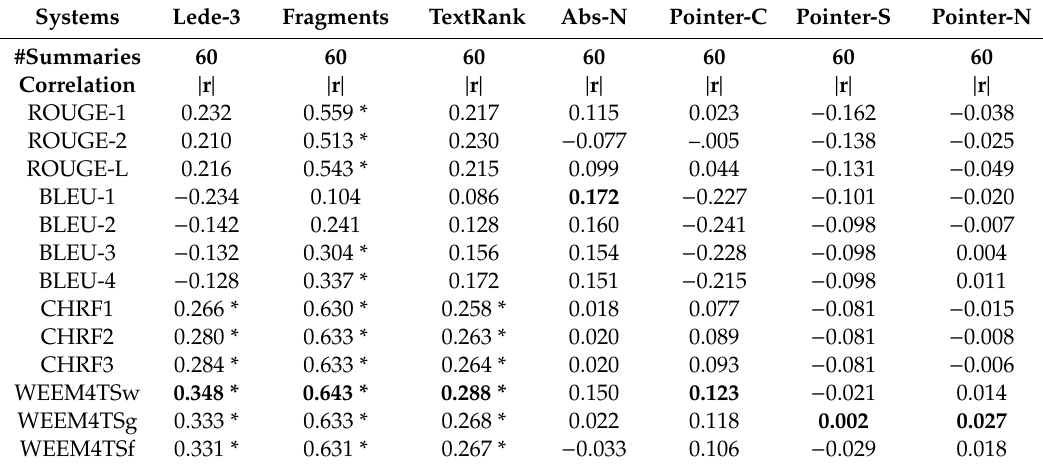
Table 6. Pearson (cid:48) s (r) correlation between automatic evaluation metrics scores and human judgments. Automatic evaluation metrics scores are computed based on reference summaries generated by WETS. The asterisk (*) shows significance is at p ≤ 0.05. The best score in that system is highlighted in